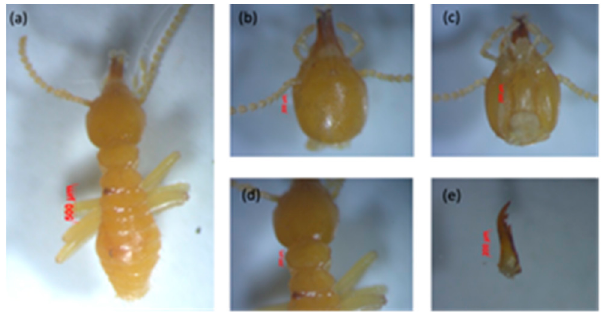
Figure 3. Minor soldier of Schedorhinotermes sp.: ( a ) body shape, ( b ) part of the head with antennas, ( c ) postmentum, ( d ) pronotum, and ( e ) left mandible.